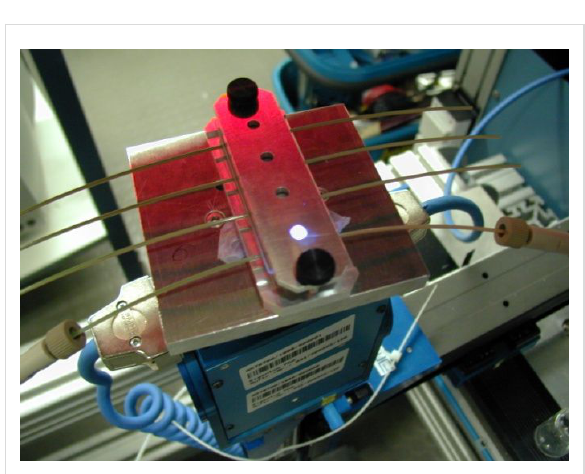
Figure 6: The miniaturized photoreactor (PEEK) during photolysis.